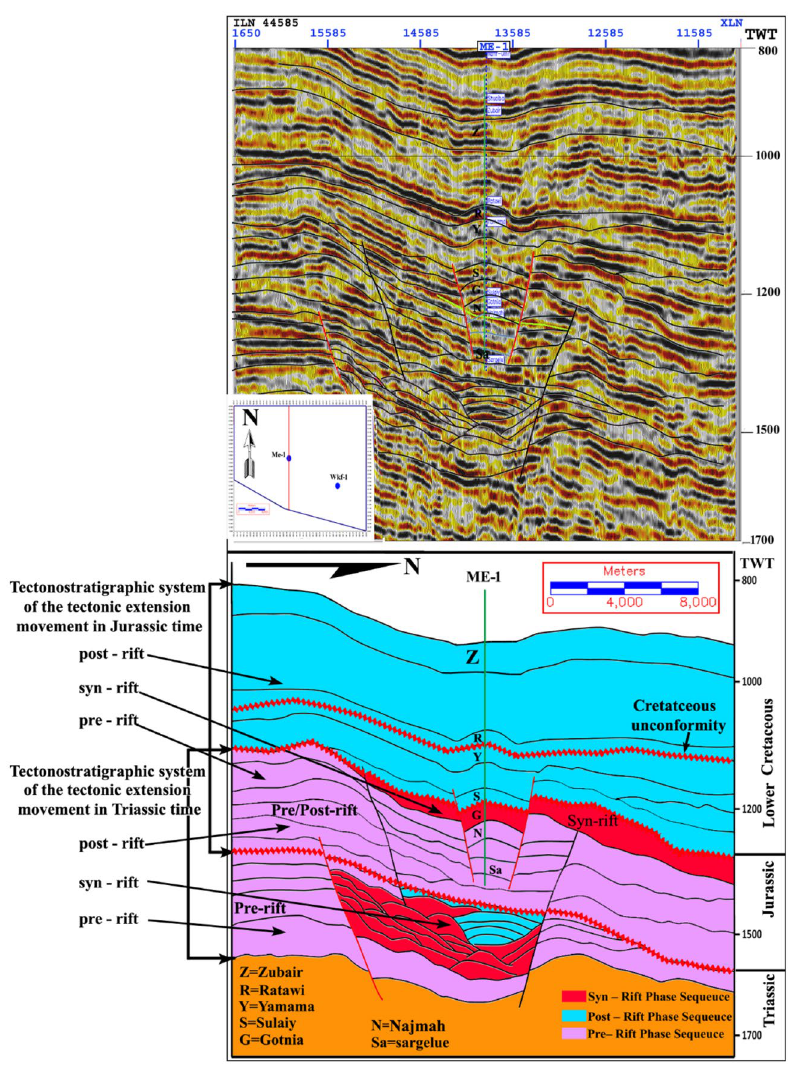
Fig. 9 Seismic section (inline 44635) shows the extensional basin in the Merjan field, fault system and tectono-stratigraphic framework. The pre-rift of tectono-stratigraphic system in Jurassic is post-rift of that for Triassic